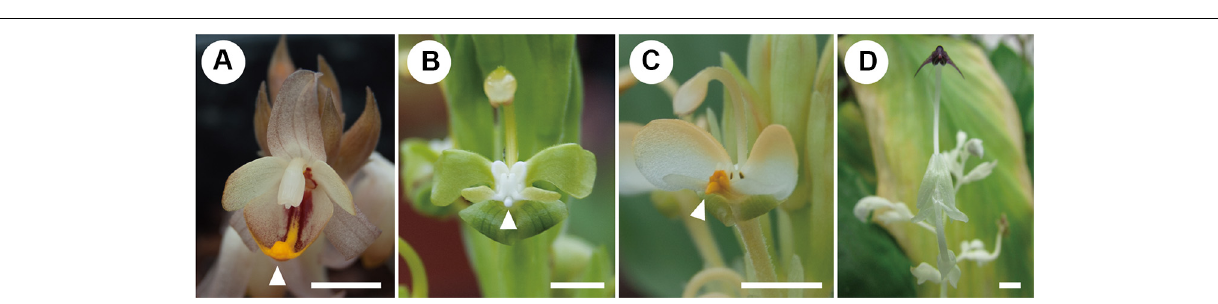
Frontiers in Ecology and Evolution |